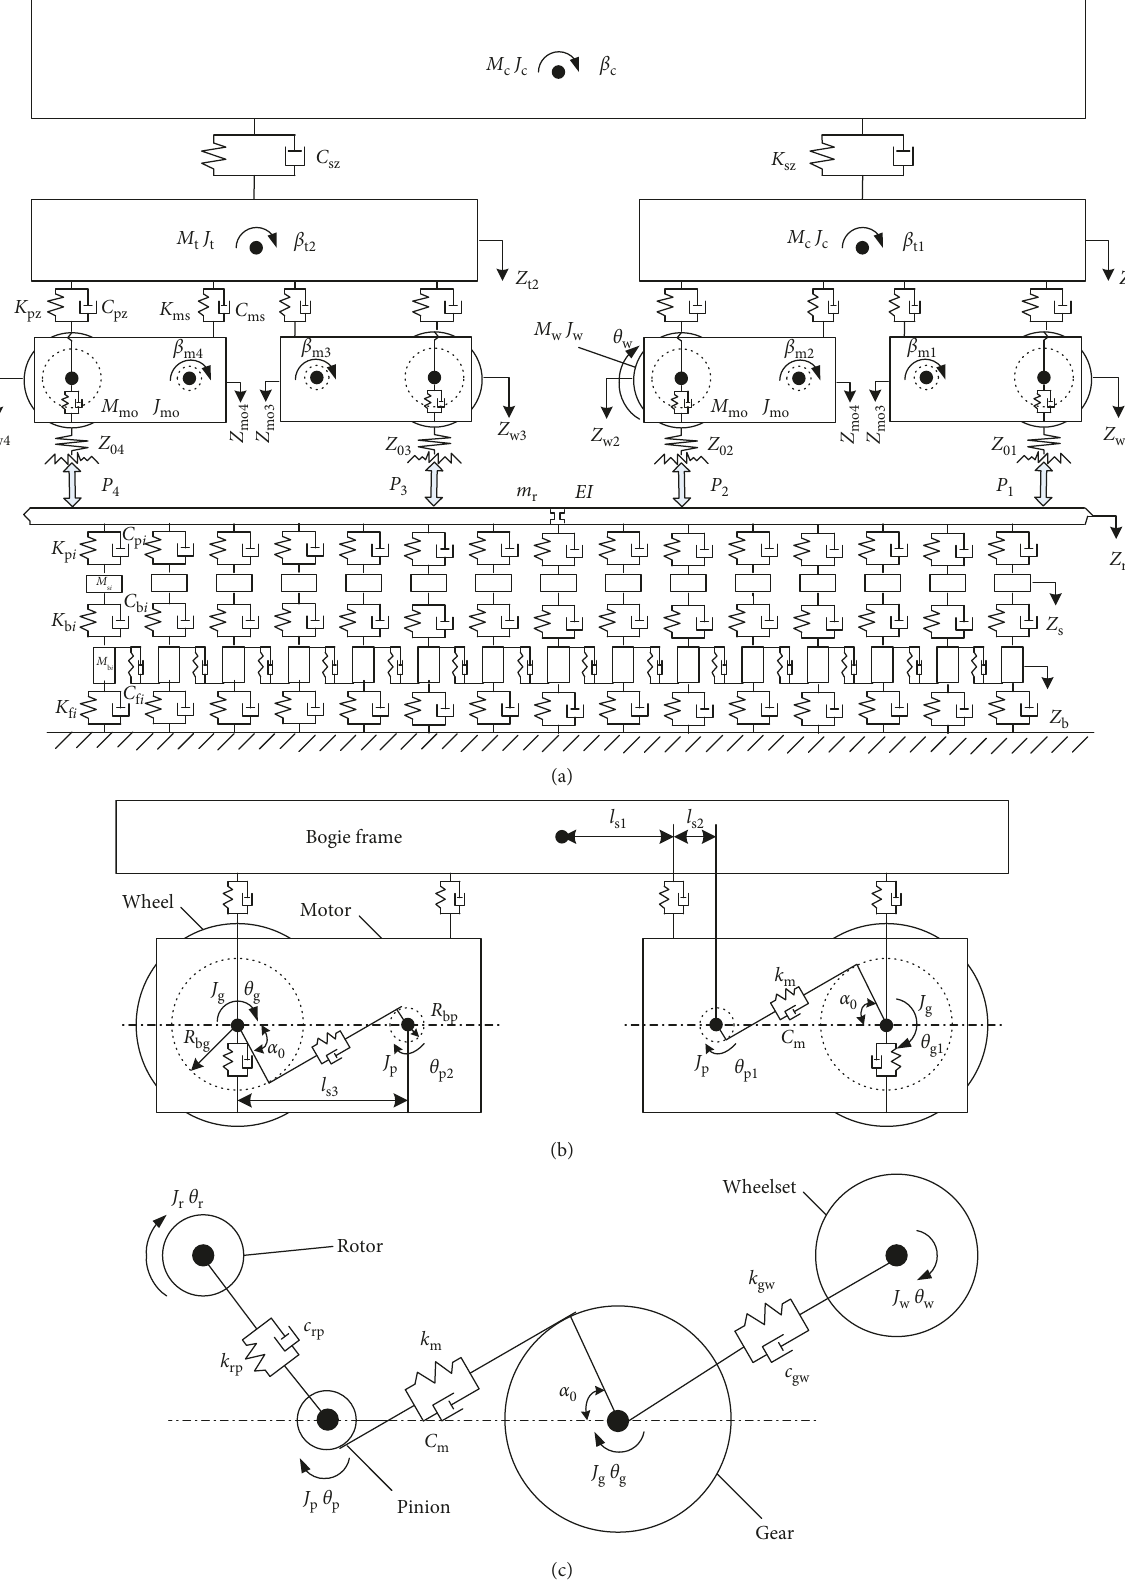
Figure 1: Vertical dynamics model of locomotive-track coupled with gear transmission: (a) total dynamic system, (b) schematic of the gear transmission, and (c) detail illustration of the gear transmission